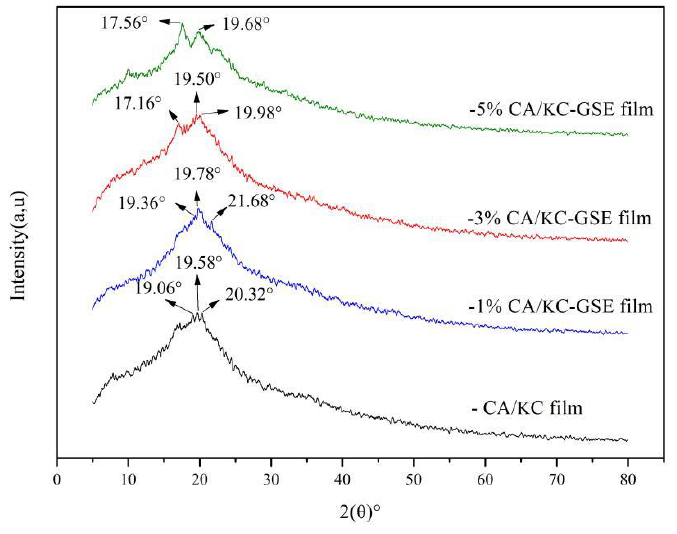
Figure 3. XRD patterns of CS/ κ C, 1% CS/ κ C-GSE, 3% CS/ κ C-GSE, and 5% CS/ κ C-GSE films.